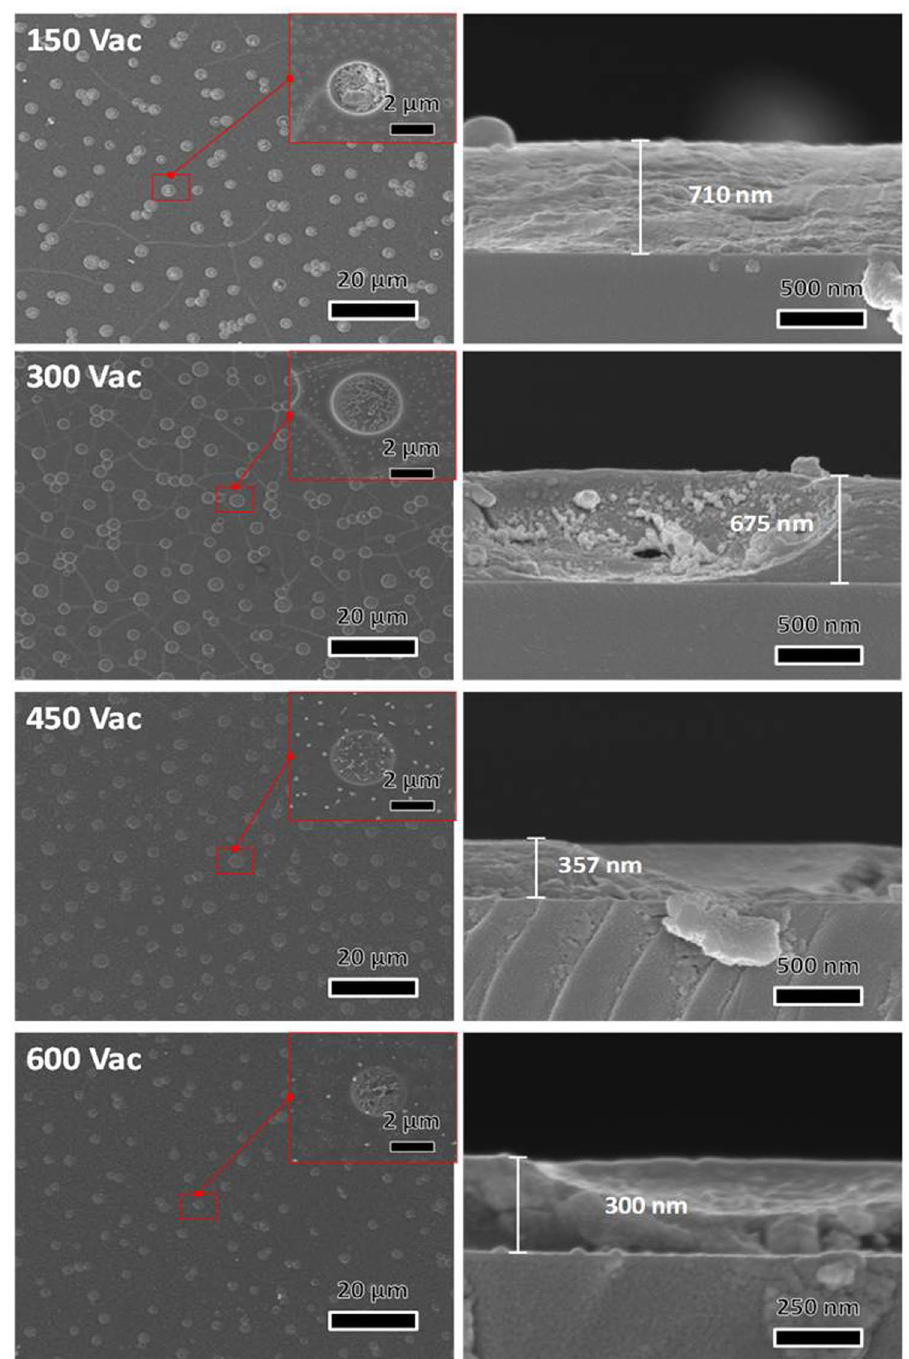
Figure 4. Surface and cross-sectional SEM images of samples annealed in Vacuum atmosphere with different temperature in the range 150 to 600